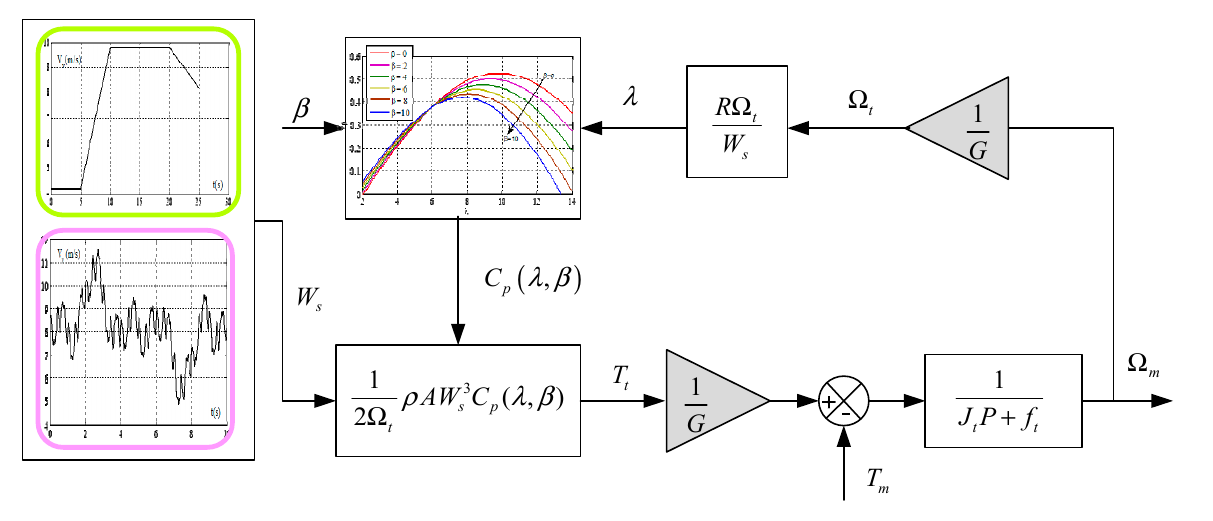
Figure 9. Variable-speed WTE general overview.